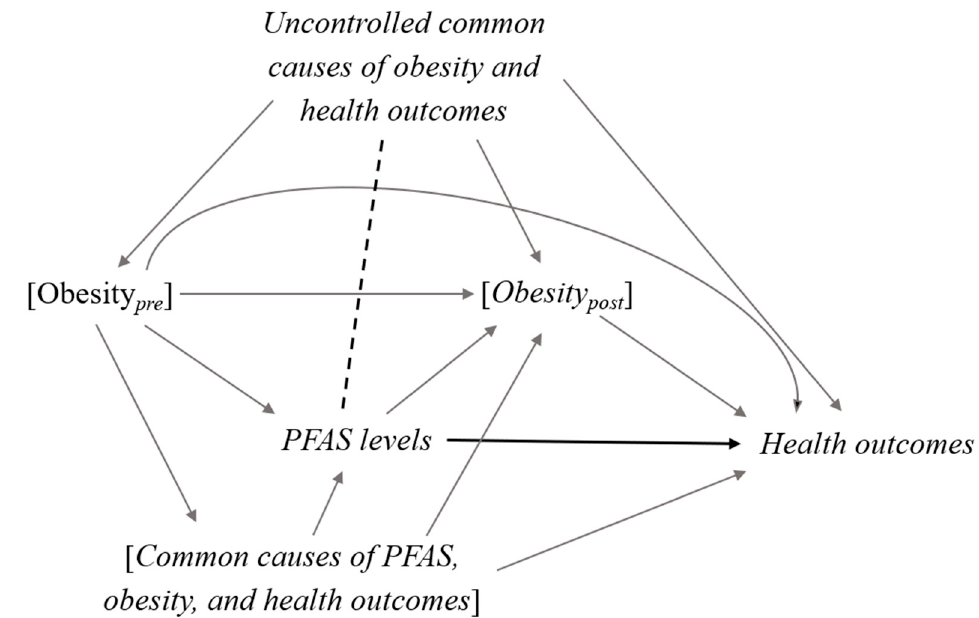
Figure 2. Collider bias due to conditioning on the measure of obesity a ff ected by PFAS when estimating the e ff ect of PFAS exposure on health outcomes. In this DAG, [ variable ] represents the adjustment of the variable. Uncontrolled common causes of obesity and health outcomes are variables that were not included in the model. Measured confounders (common causes between the exposure and outcome) and obesity pre should be adjusted to remove confounding (backdoor) paths between PFAS and health outcomes. However, conditioning on obesity post will (i) close a causal mediating path between PFAS exposure on health outcomes, and (ii) induce a biasing path via uncontrolled common causes of obesity post and health outcomes (i.e., via a spurious association between PFAS and uncontrolled common causes of obesity post and health outcomes as indicated by the dash line in this DAG). The latter is also known as “collider bias”.